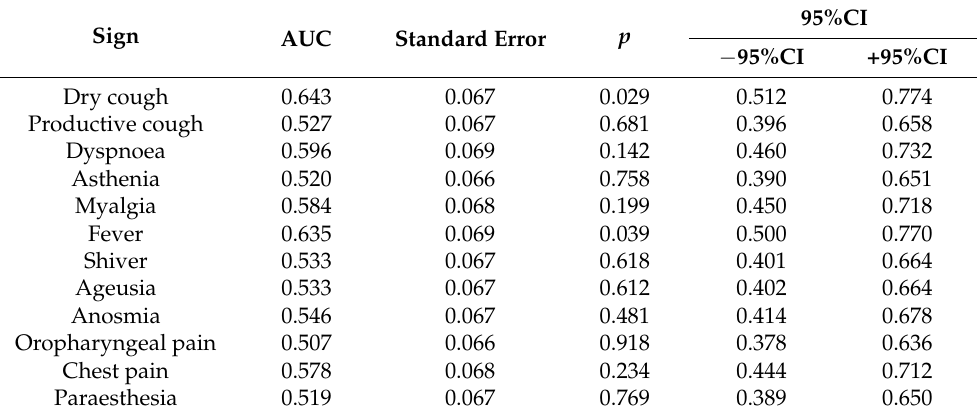
Table 3. The sensitivity/specificity balance of signs and symptoms in the determination of pneumonia in patients with SARS CoV-2.